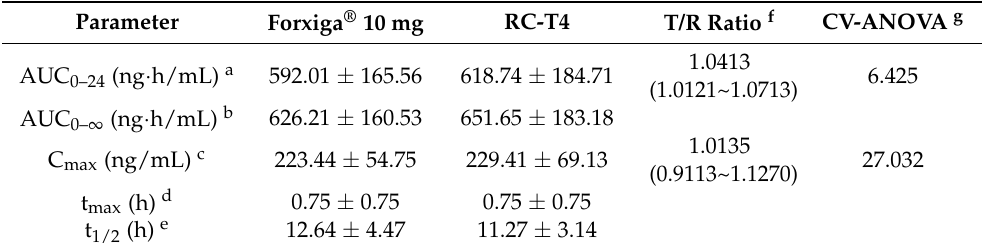
Table 5. PK parameters of dapagliflozin (DAP) after oral administration of Forxiga ® 10 mg and RC-T4 in healthy